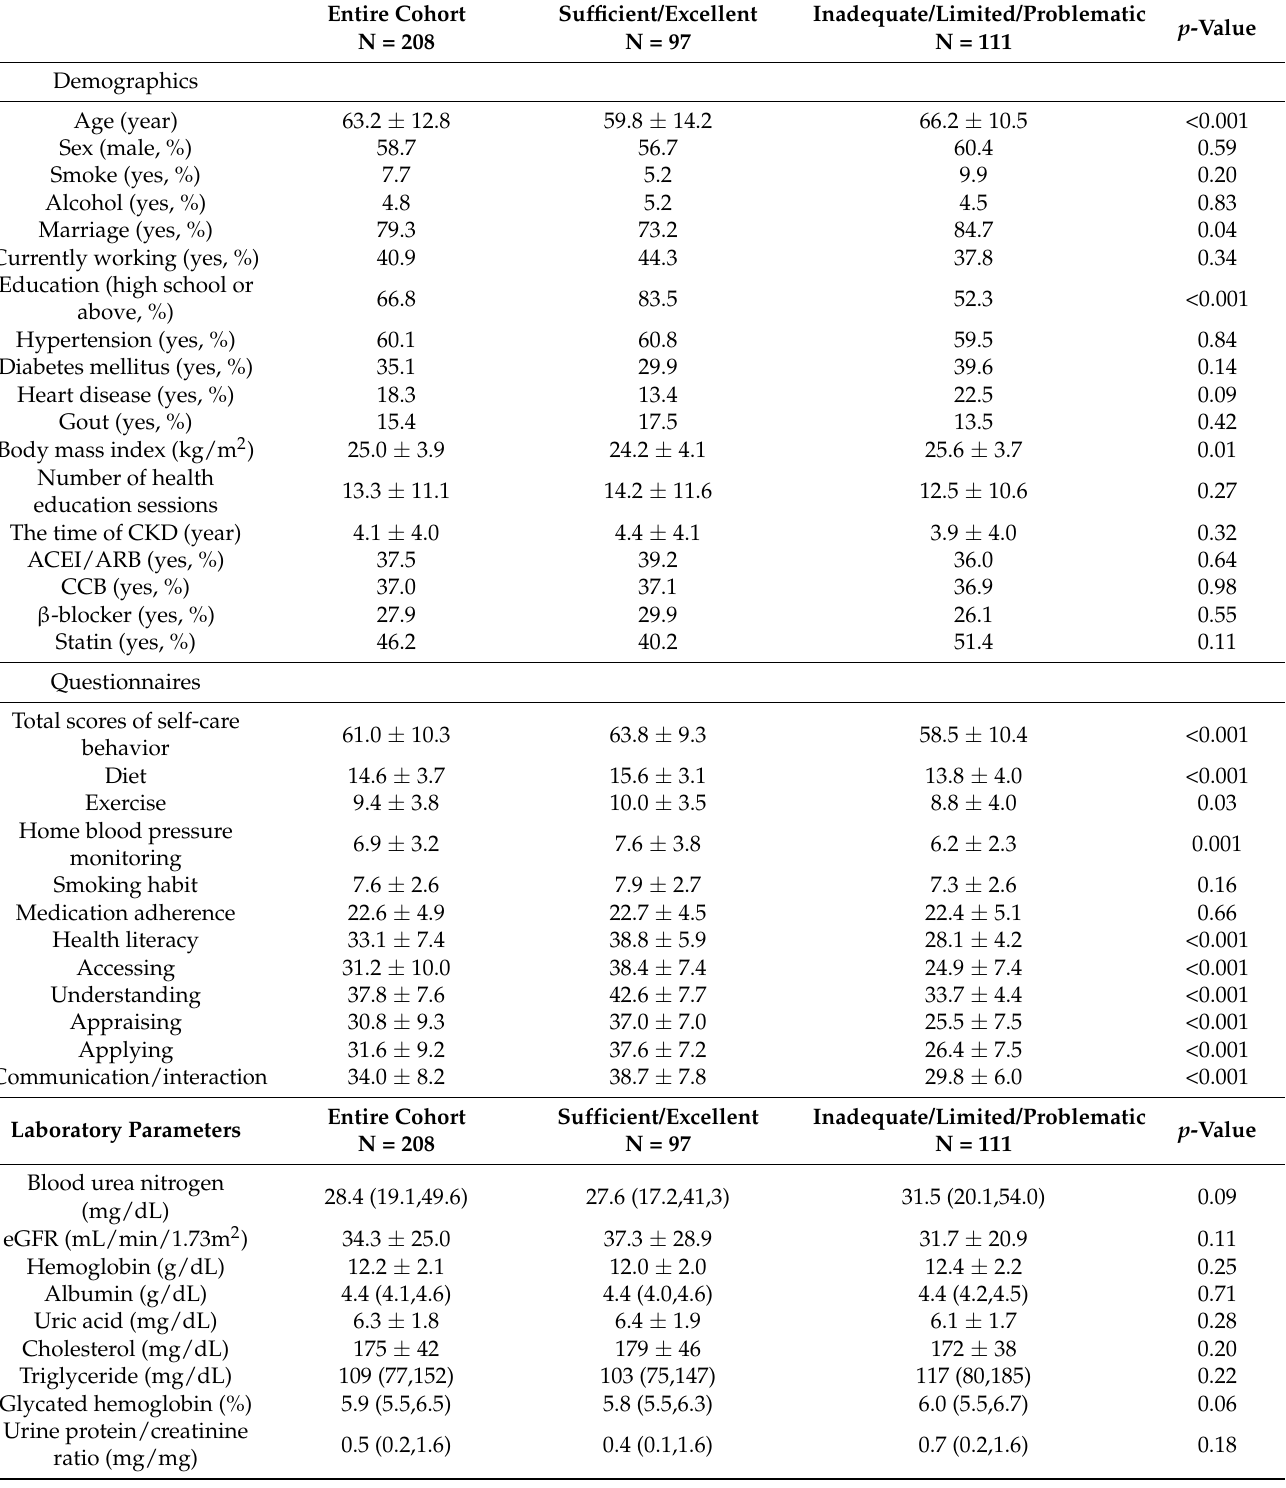
Table 1. The clinical characteristics of study subjects stratified by health literacy in CKD